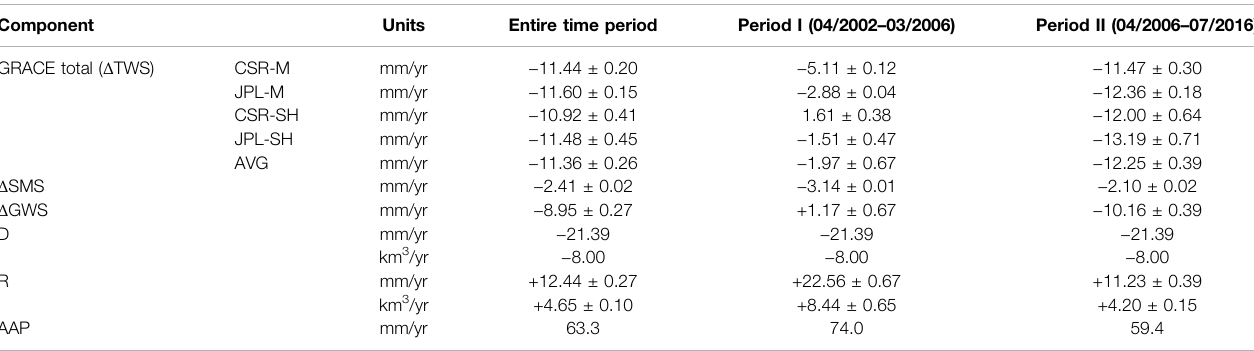
TABLE 2 | GRACE-estimated Δ TWS components over the Saq aquifer.